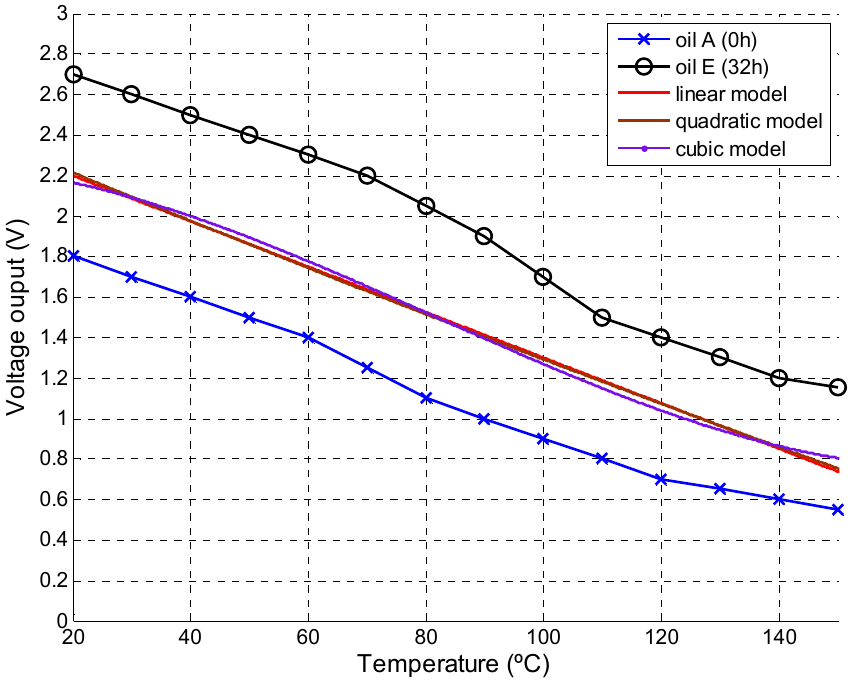
Figure 13. Regression models to extract the temperature dependency. (All samples were considered, Oil